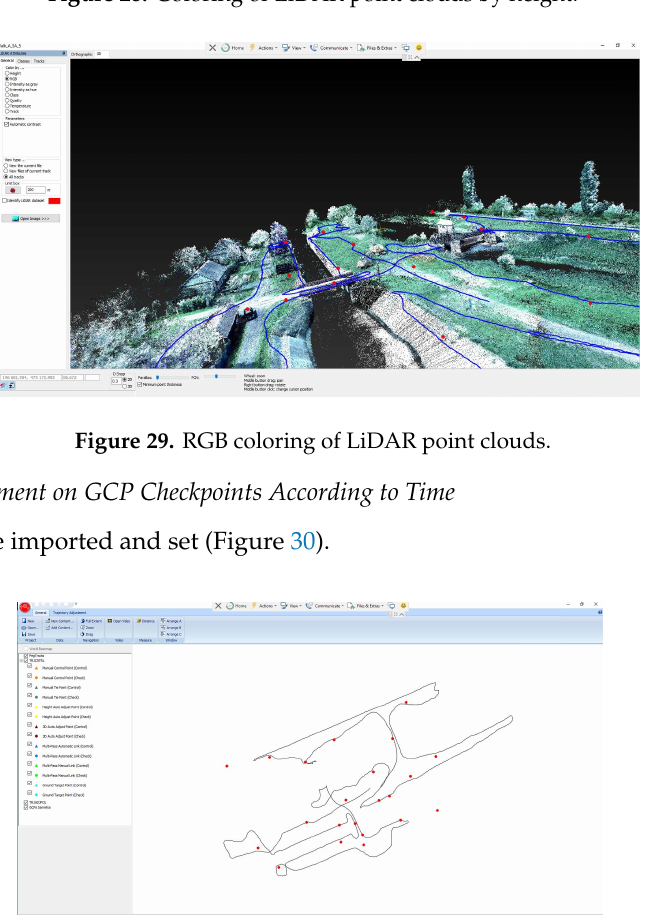
Figure 31. LiDAR measurement trajectory control. Next, the video option will be open in order to view the GCP checkpoints and adjust them according to time (Figures 32 and 33). Figure 32. Adjustment on GCP No.1.